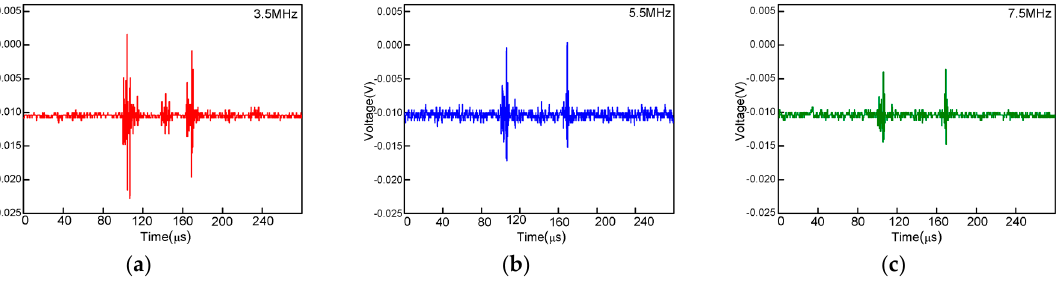
Figure 7. ( a ) Sensor response to one-cycle 1 MHz ultrasonic pulse signals with a frequency of 3.5 MHz; ( b ) 5.5 MHz; ( c ) 7.5 MHz.